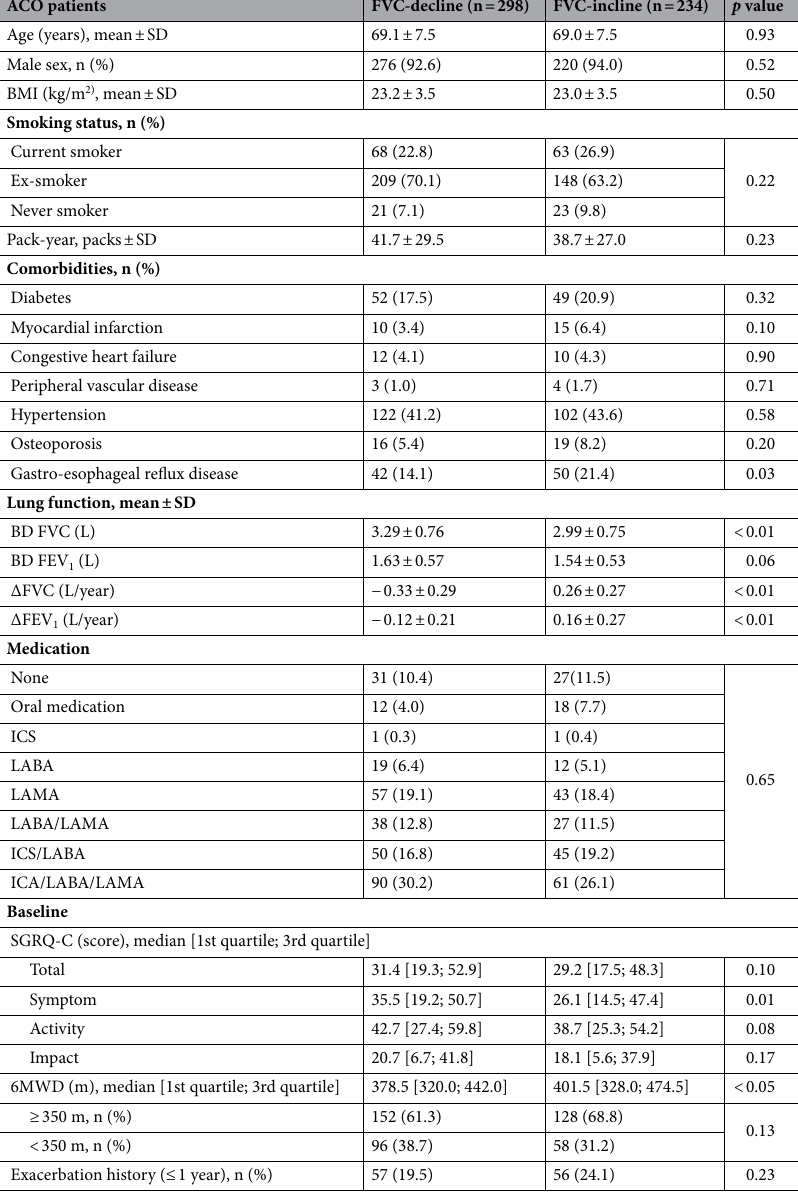
Table 1. Demographics according to FVC changes. Demographic data were summarized in Table 1. FVC- decline group showed lower underlying gastroesophageal reflux and higher baseline FVC compared to FVC- incline group. FVC-decline group have higher SGRQ-C symptom score and lower 6MWD than FVC-incline group. ACO asthma-chronic obstructive pulmonary disease overlap, BD post-bronchodilator, BMI body mass index, Δ annual changes of the postbronchodilator values, FEV 1 forced expiratory volume in one second, FVC changes of forced vital capacity, SD standard deviation, SGRQ-C St. George’s Respiratory Questionnaire- Chronic obstructive pulmonary disease specific version, 6MWD 6-min walking